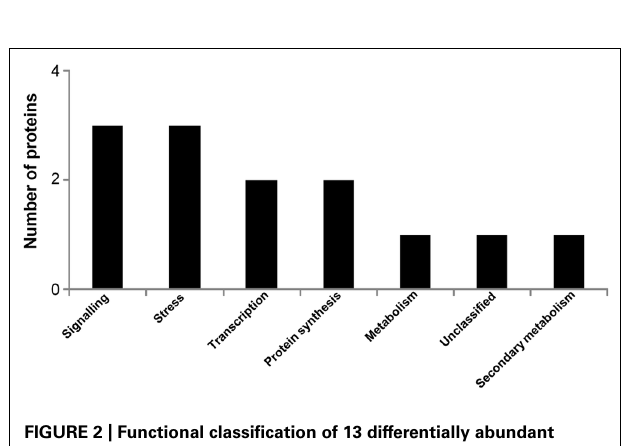
FIGURE 2 | Functional classification of 13 differentially abundant proteins detected on 2-DE gels of p I 4–7 between mature flax seeds of first generation harvested from non-radioactive and radio-contaminated Chernobyl